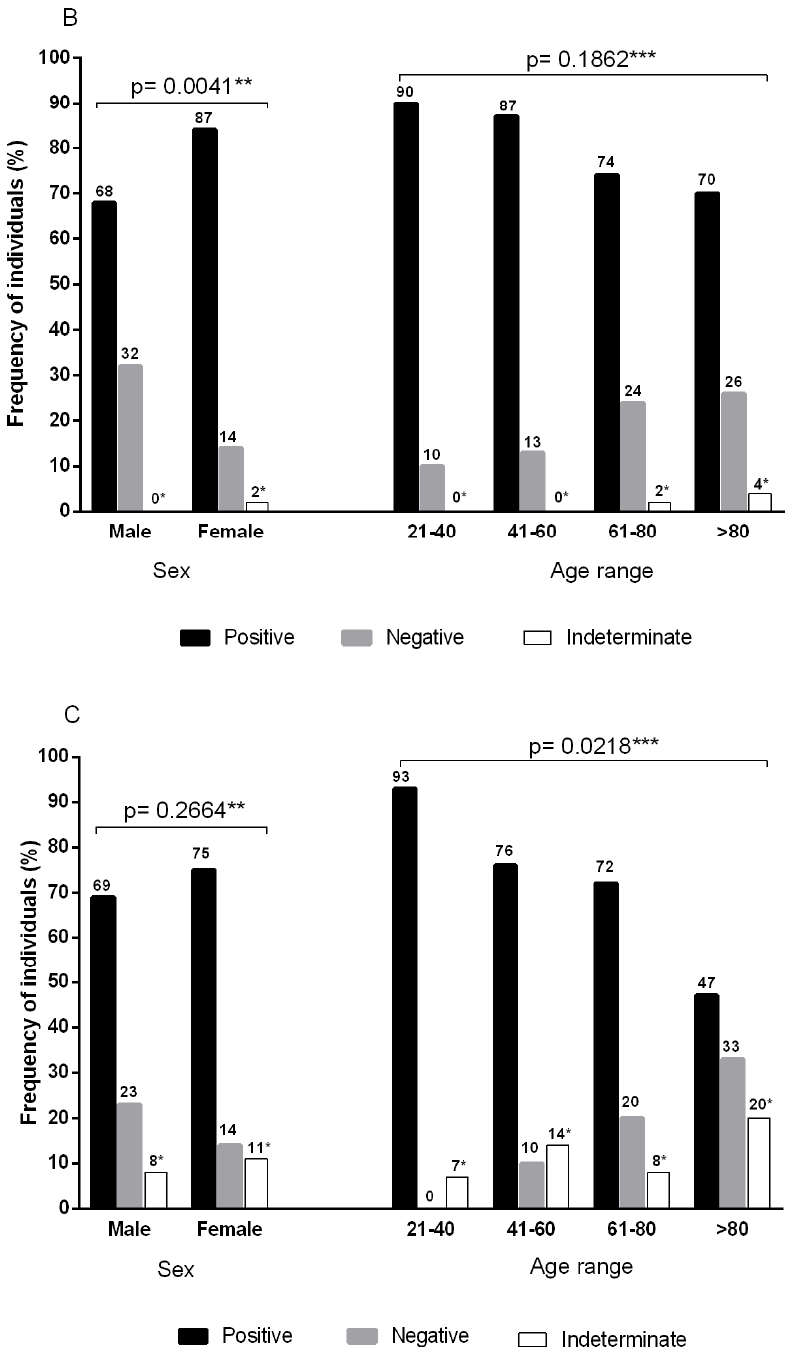
142 Figure 1. Frequencies of anti-SARS-CoV-2 antibodies according to sex and age group. ( A ) Pooled